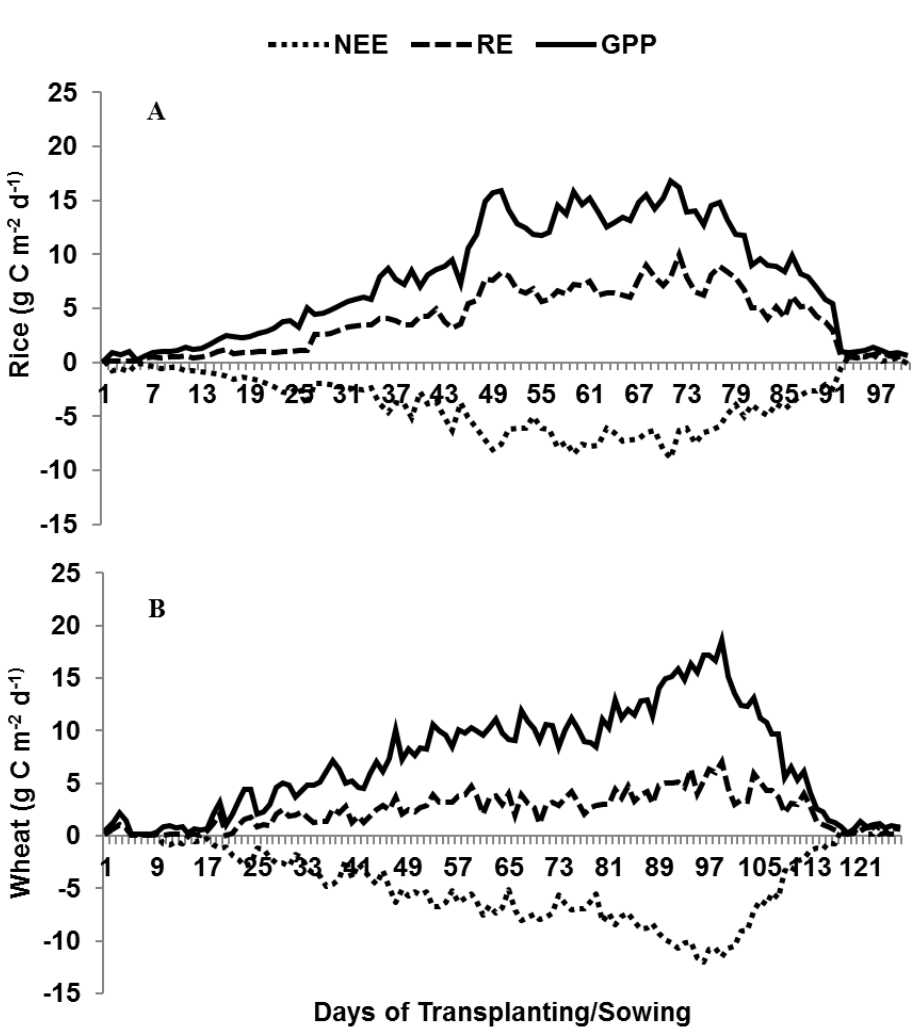
Figure 4. Daily mean net ecosystem exchange (NEE), gross primary productivity (GPP) and ecosystem respiration (RE) at different growth stages of rice ( A ) and wheat ( B ) in northwestern Indo-Gangetic Plains (IGP).